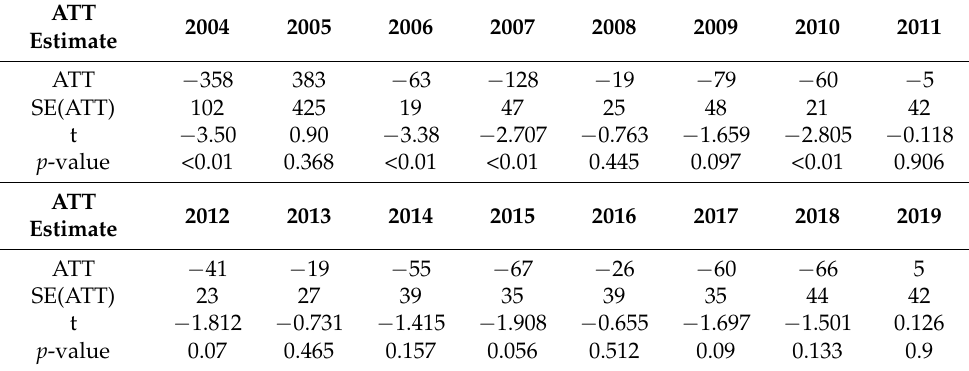
Table 4. Average effect of the impact of “green” CAP payments on profitability of farms (EUR/ha).